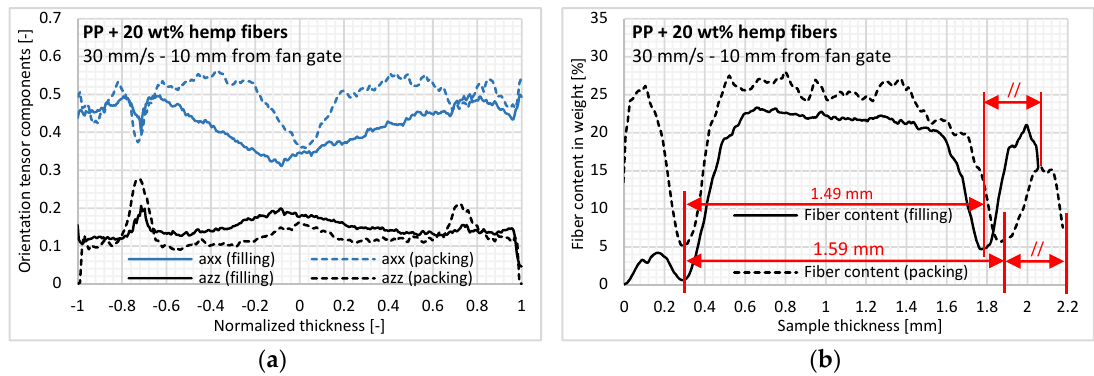
Figure 9. Effect of packing pressure on ( a ) fiber orientation state and ( b ) in-thickness fiber content.